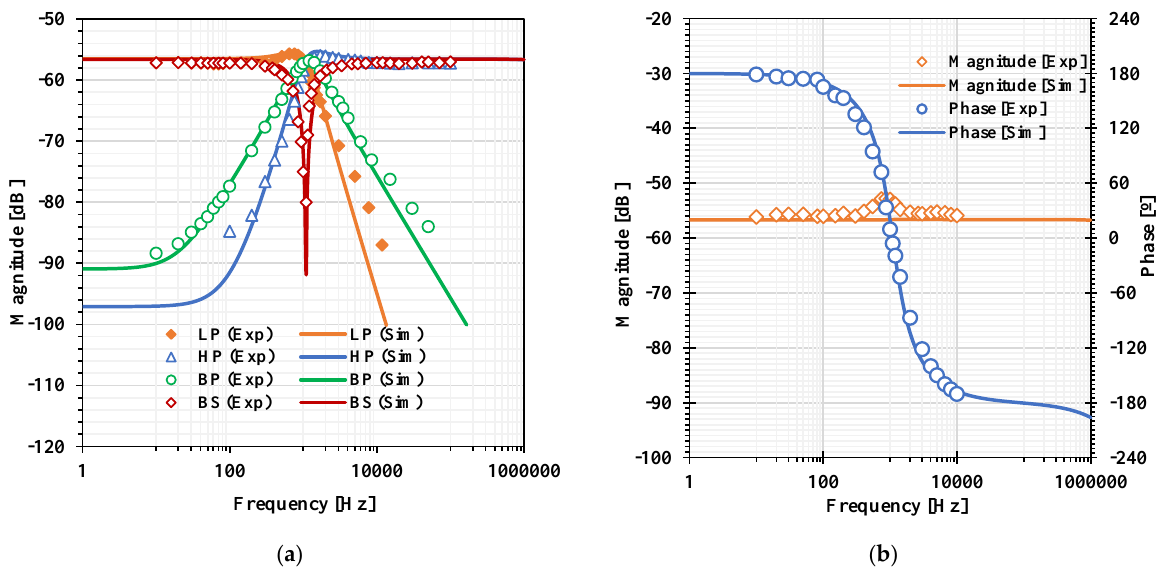
Figure 19. Experimental frequency responses of the TAM filter: ( a ) LP, BP, HP, BS filters; ( b ) AP filter.